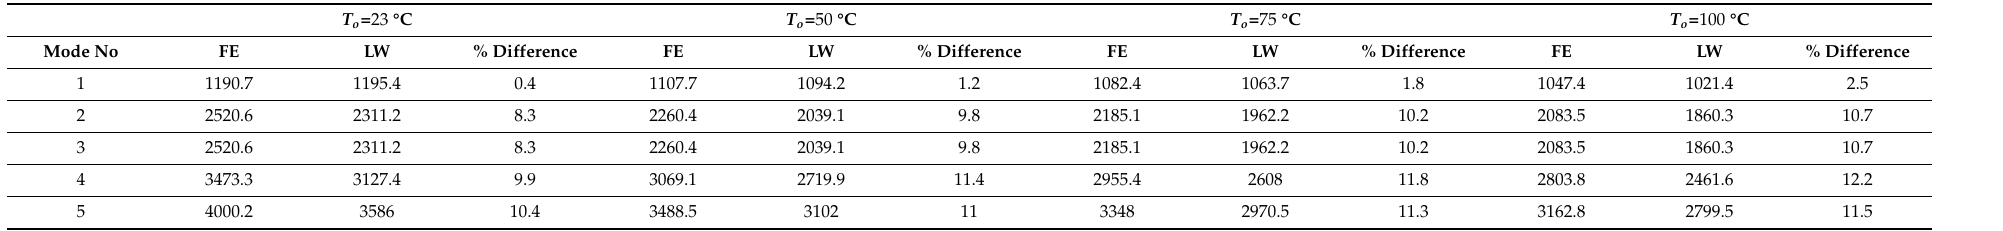
= 20 , a = 1, h 1 = 0.1 h 2 = 0.02 , h 3 = 0.76, h = 12 mm, k w = 0, K = h b h h h